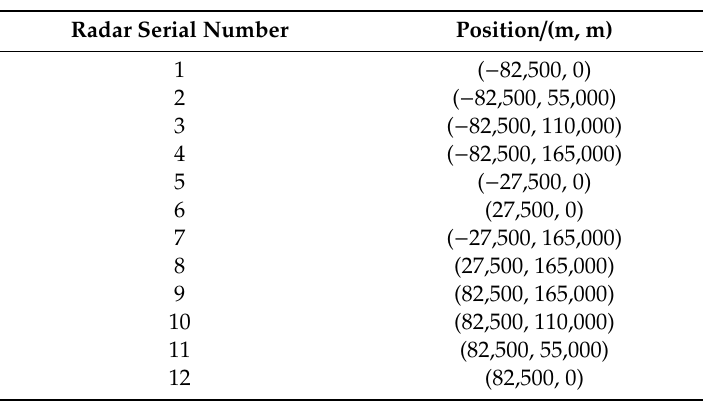
Table 3. Position parameters of radars.